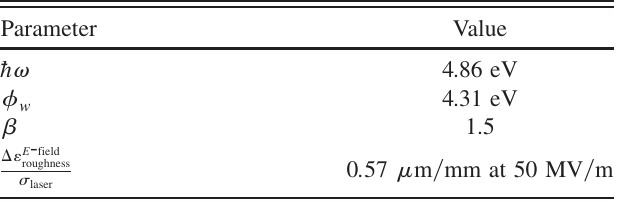
TABLE I. Nominal parameters of a copper cathode for thermal emittance model fitting simulation.